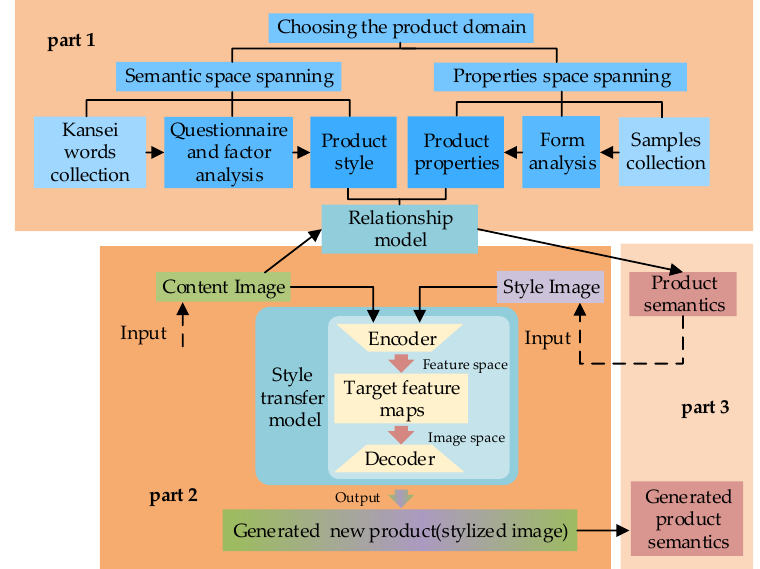
Figure 1. The Kansei engineering-based neural style transfer for product innovation (KENPI) framework. The framework contains of three parts. In part 1, a relationship model of the product semantics and the product properties is constructed. By training the relationship model, we can predict product style through its properties. In part 2, a style transfer model is constructed. By training the style transfer model, we can turn the content image and style image into a stylized image, which is the generated new product. In part 3, the semantics of products are